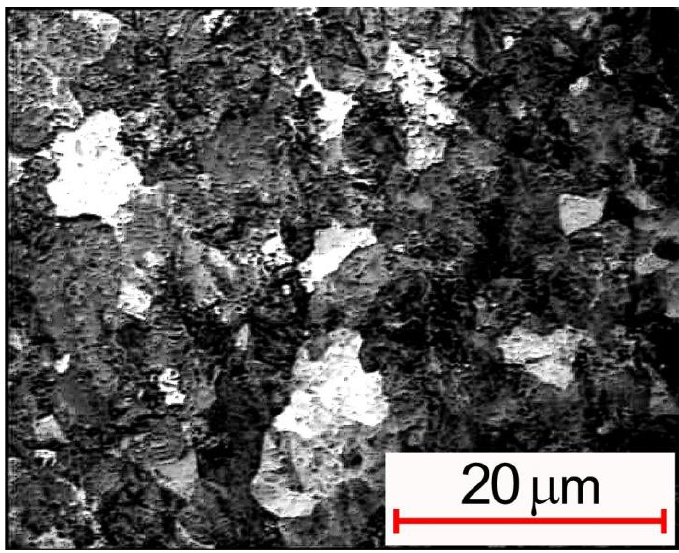
Figure 4. Microstructure of the base metal of the E76HGF rail.